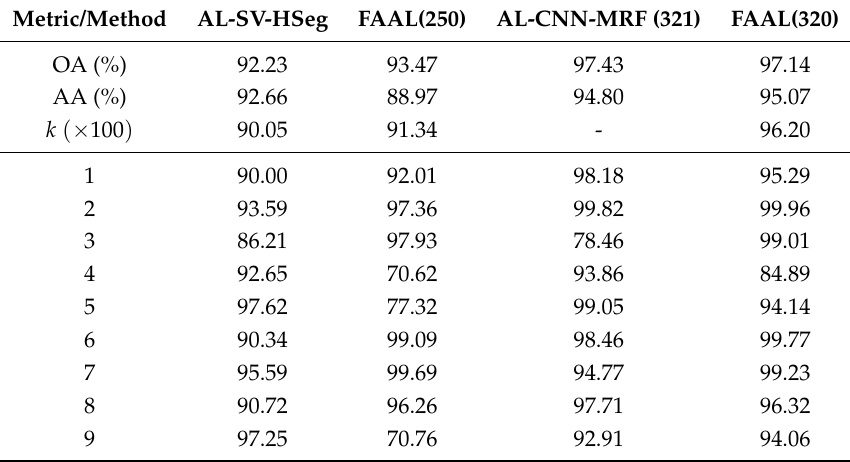
Table 6. Comparison of active classifiers and FAAL on Pavia University.